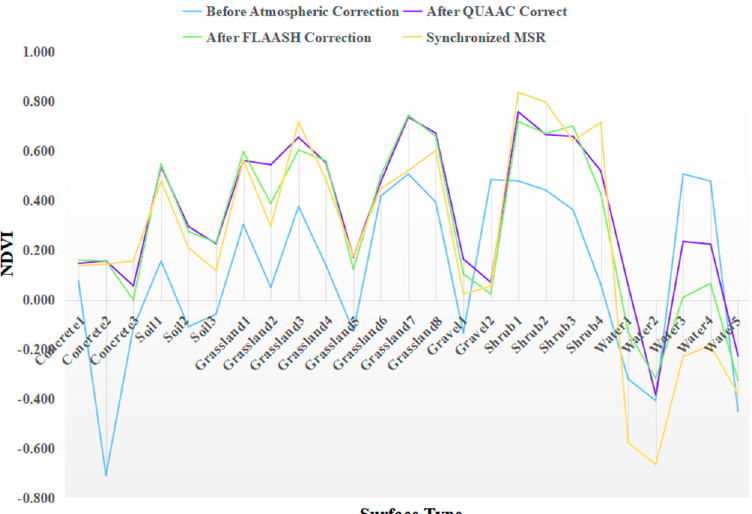
Figure 4. NDVIs of concrete floor, soil, grassland, gravel, shrubs, and water before and after QUAAC and FLAASH correction and synchronized MSR. The blue represents the NDVI before atmospheric correction, the purple represents the QUAAC − corrected NDVI, the green represents the FLAASH − corrected NDVI, and the orange represents the NDVI of synchronized MSR.